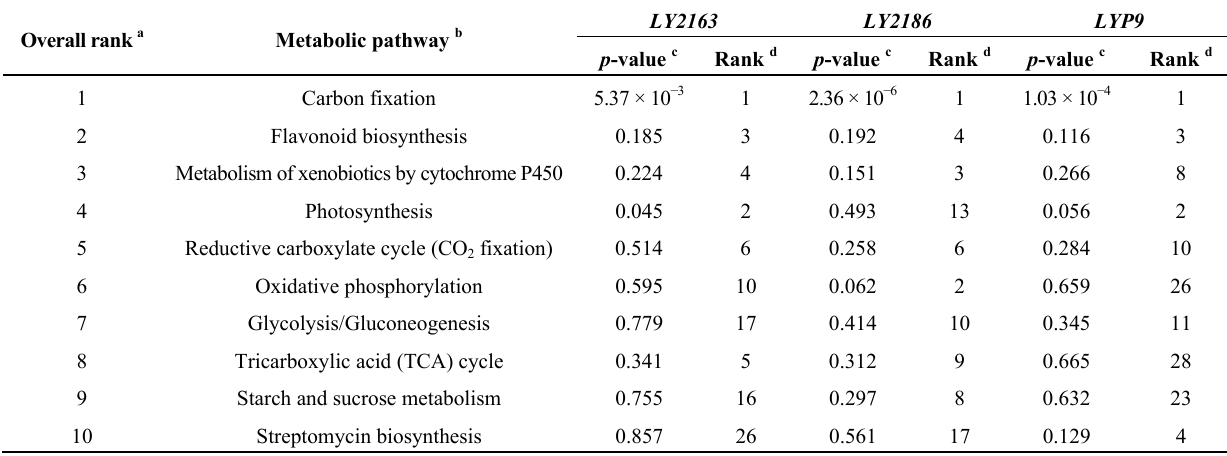
Table 2. The top ten DG-enriched metabolic pathways in the three hybrid rice